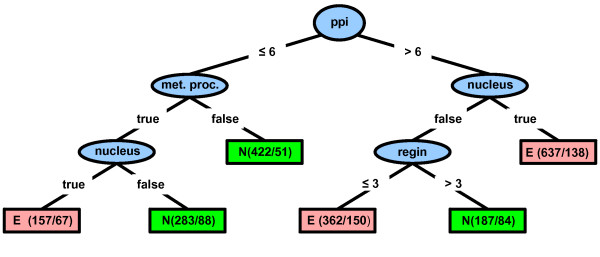
Decision tree generated by training the J48 algorithm on the balanced dataset 8 with all available data. This decision tree was generated by training the J48 algorithm on the balanced dataset 8 with all available data (see "Methods"). The uppermost ellipse is the node root of tree that represents the most important condition for discriminating essential genes from non-essential genes. In this case, such condition is the number of protein physical interactions (ppi). The remaining ellipses are internal nodes that represent additional conditions for considering a gene as essential or non-essential. In the left branch of tree, such conditions are involvement in a metabolic process (met. proc.) and nuclear localization (nucleus). In the right branch, such conditions are nuclear localization (nucleus) and number of regulating transcription factors (regin). The rectangles are the leaf nodes that represent the final classification. Red and green rectangles depict genes that, under certain conditions (represented by the root node and internal nodes), are respectively and predominantly classified as essential (E) and non-essential (N). In the round brackets inside rectangles, the number before the slash indicates the total number of genes that are actually essential or non-essential and the number after the slash indicates how many genes were incorrectly predicted.